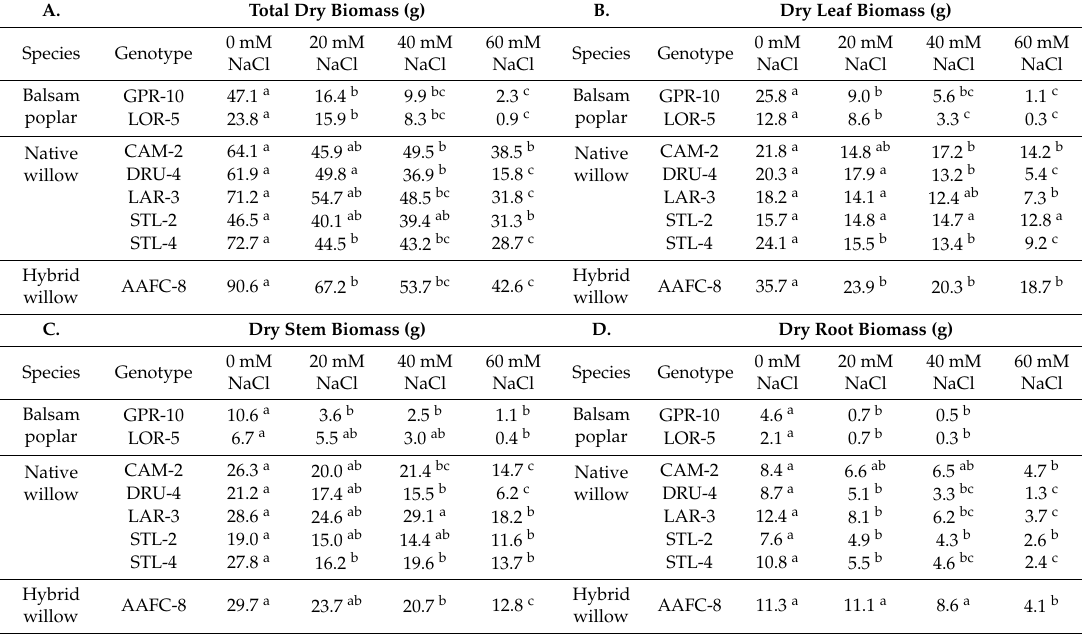
Table 1. Average total dry biomass (A), leaf (B), stem (C), and root biomass (D) of poplar, willow, and hybrid willow genotypes from the second salinity trial ( n = 9 for each genotype and treatment). A.